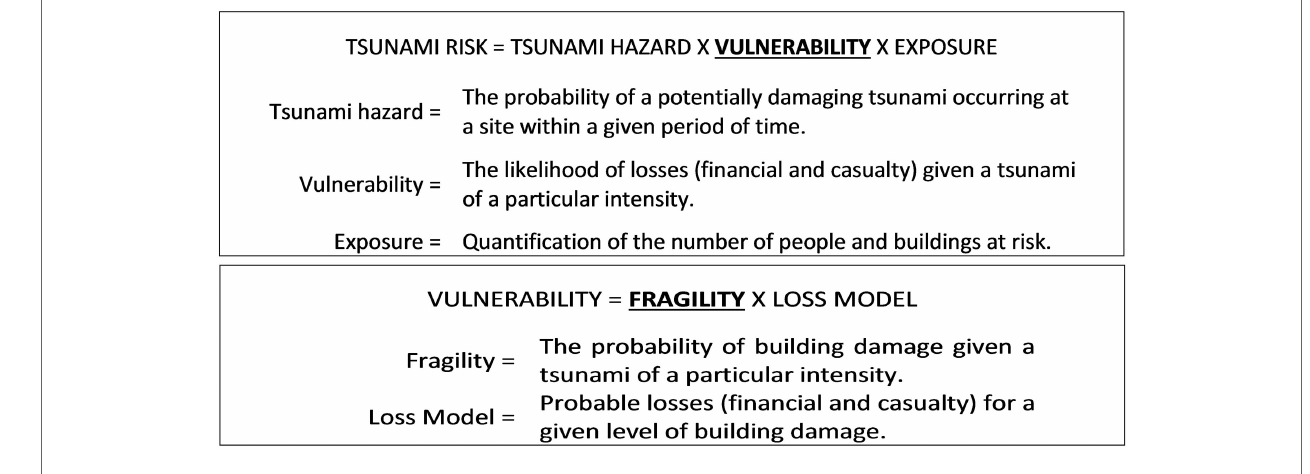
FIGURE 1 | The components of tsunami risk. Fragility is highlighted as it is the focus of this paper.